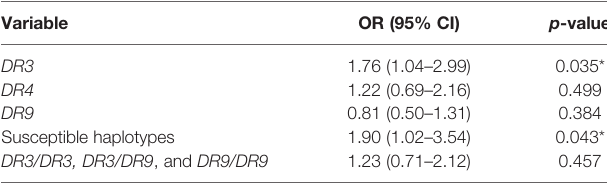
TABLE 4 | Association of the frequency of GADA binding to multiple epitopes of GAD65 with the frequencies of HLA-DR-DQ haplotypes and genotypes.